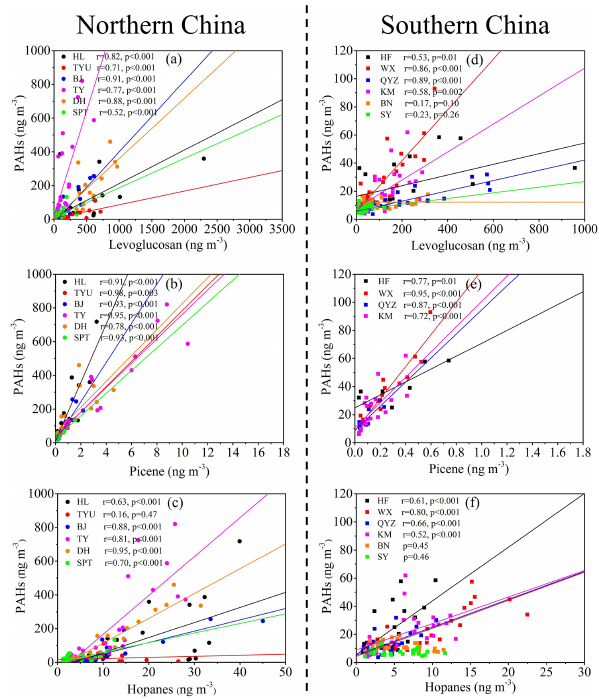
Figure 6. The correlation between PAHs and levoglucosan, picene and hopanes at sites in northern China (a–c) and southern China (d–f) .